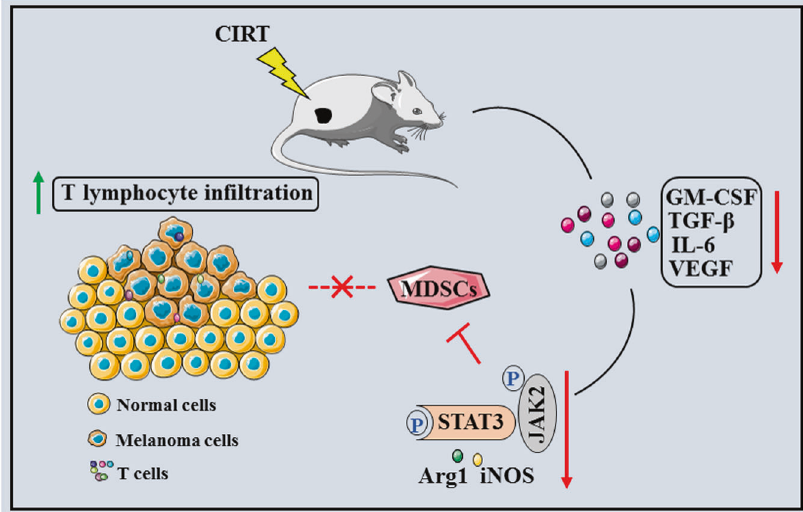
Fig. 6 Schematic of the mechanism of CIRT boosts anti-tumour immune responses in melanoma-bearing mice. Carbon ion radiotherapy enhances anti-tumour immune responses by inhibiting myeloid-derived suppressor cells through a JAK2/STAT3-dependent signalling